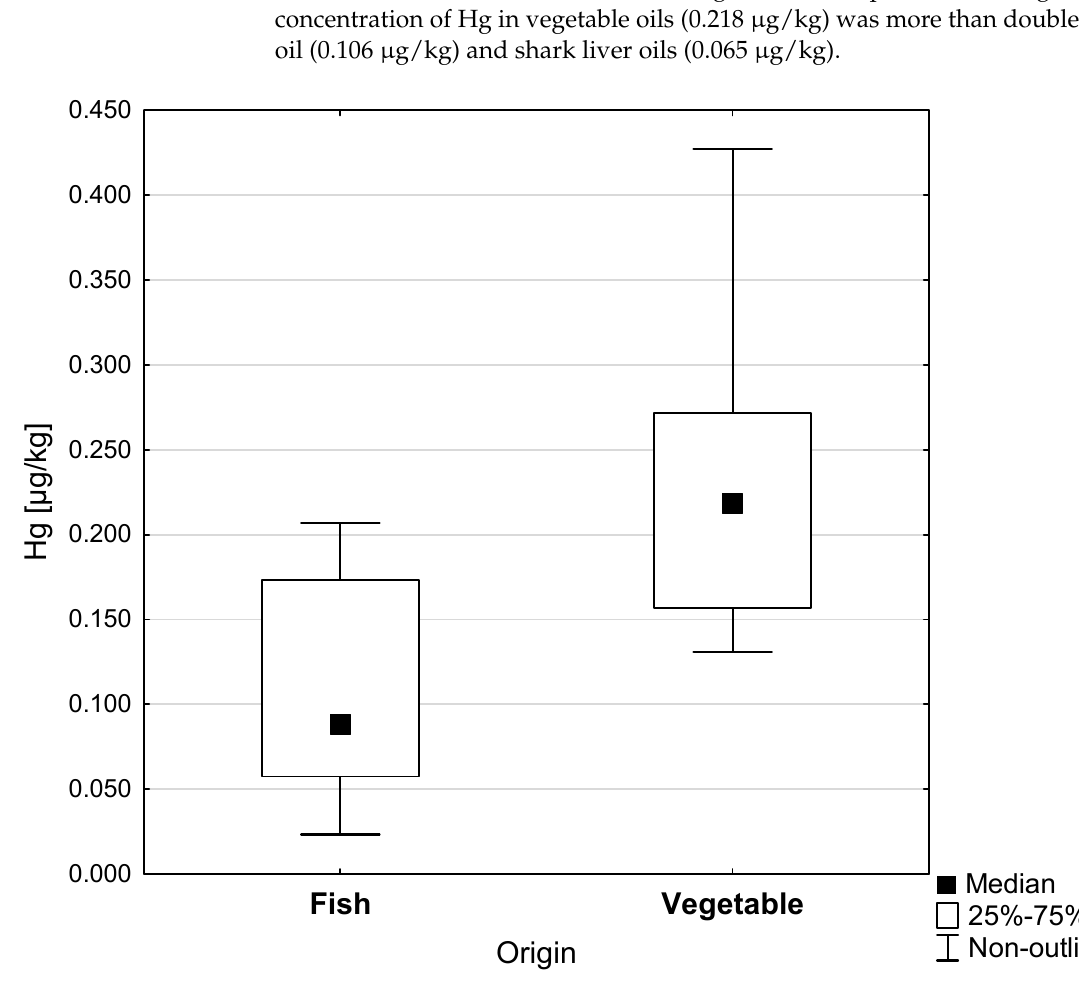
Figure 1. Hg concentrations in dietary supplements made of fish and vegetable oils (µg/kg).